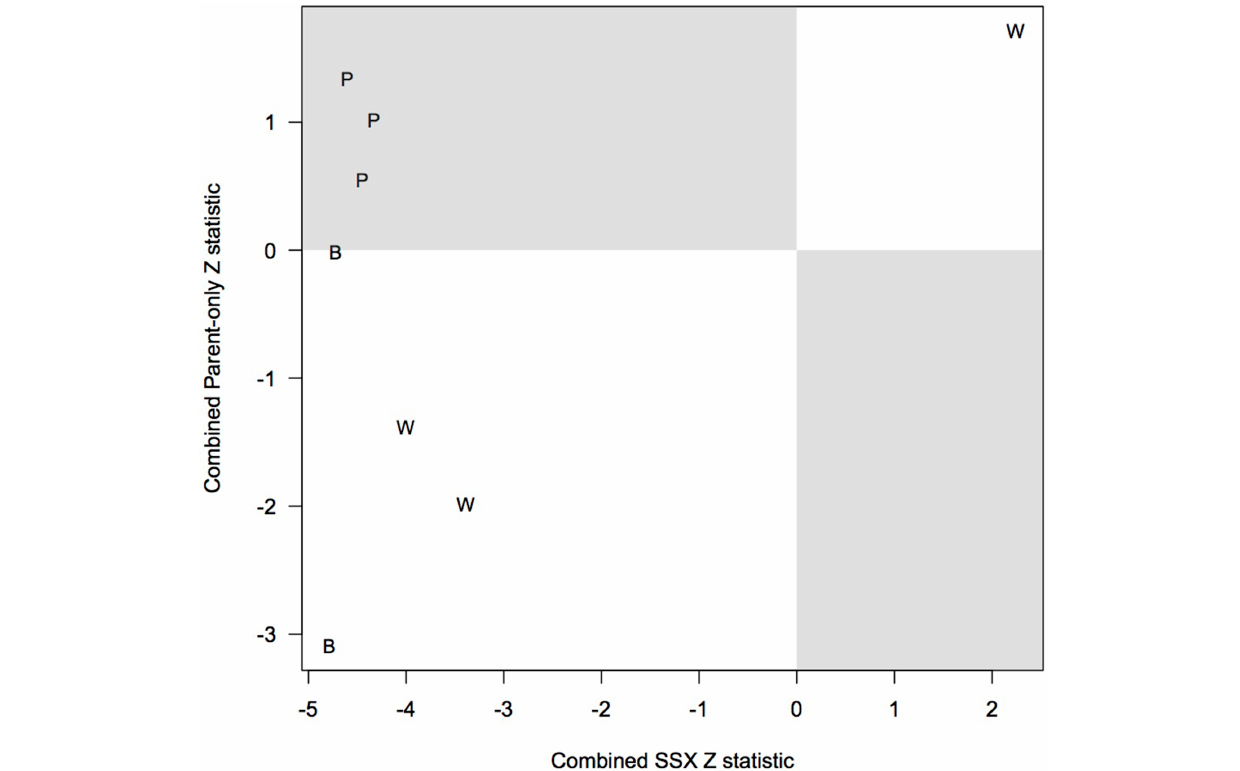
SSX analyses assume the relative risk in affected daughters is log-additive in the number of copies of the variant allele. A combined score is used to combine the sex-specific statistics. “B” represents SNPs in the top 5 under both analyses, “P” represents SNPs that were in the top 5 for Patel et al. (2013) but not for us, “W” represents SNPs that were in the top 5 for our analysis but not Patel et al.